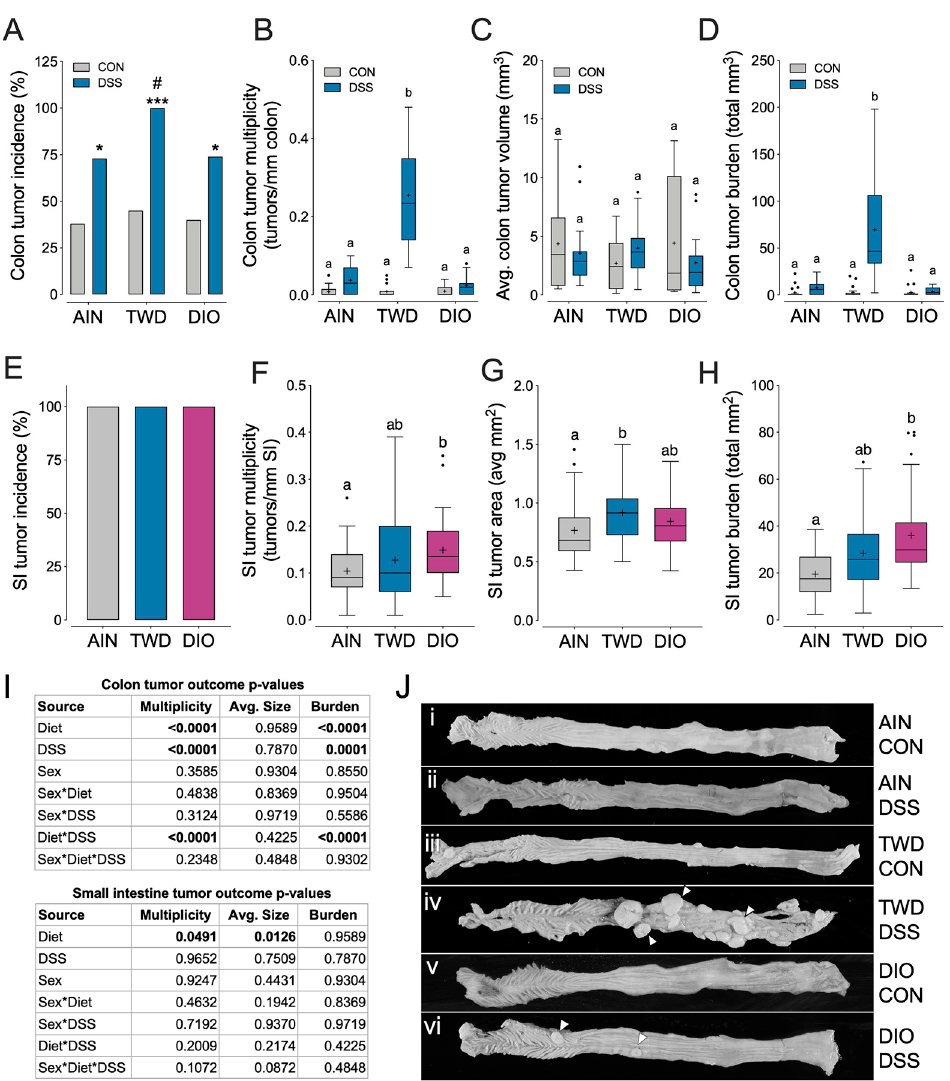
Figure 3. TWD promotes inflammation-associated colon tumorigenesis in Apc Min /+ mice, but does not markedly alter small intestine tumor development (Experiment C). Apc Min /+ female and male mice were fed a standard diet (AIN), the total Western diet (TWD) or the 45% fat diet-induced obesity diet (DIO) for 12 weeks. Half the mice were provided 1% DSS via drinking water for two weeks. ( A ) Incidence of colon tumors shown as the percent of mice with tumors. * p < 0.05, *** p < 0.001 for comparisons of DSS to CON group within each diet and # p < 0.05 for comparison across diet groups within CON or DSS cohorts as determined by the Chi-square test. ( B–D ) Data shown include colon tumor multiplicity ( B ), average size of colon tumors (as volume) ( C ) and colon tumor burden (as total volume) ( D ). ( E ) Incidence of small intestine tumors shown as the percent of mice with tumors. ( F–H ) Data shown indicate small intestine (SI) tumorigenesis endpoints for diet and DSS treatment, including SI tumor multiplicity ( F ), average size of SI tumors (as area) ( G ), and burden of SI tumors (as total area) ( H ). Data in B–D and F–H are shown as Tukey box plots (box, 25th to 75th percentiles; whiskers, 1.5 IQR; + , mean) ( n = 18 to 22). Di ff erent letters indicate that groups are significantly di ff erent ( p < 0.05) as determined by the appropriate linear mixed model or nonparametric test. For SI tumor outcomes, comparisons were made by diet group only as no main e ff ect of or interaction with DSS was observed. ( I ) Main e ff ect p -values for diet, DSS treatment, sex and all possible interactions are indicated to the right of charts for colon tumor data (top) or SI data (bottom). ( J ) Gross pathology images depicting colon tissues representative of each diet treatment group as follows: i, AIN and no DSS; ii, AIN + DSS; iii, TWD and no DSS; iv, TWD + DSS; v, DIO and no DSS; vi, DIO + DSS. White arrows indicate large colon tumors easily visible via low magnification light